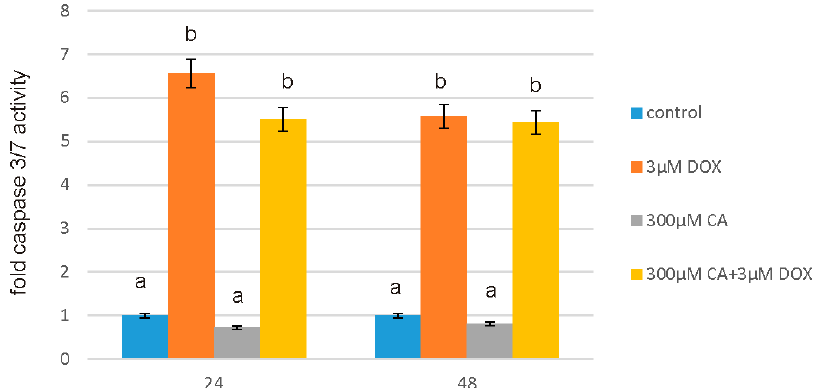
Figure 4. The effect of DOX, CA and CA + DOX on caspase 3/7 activity in fibroblast cells. The cells were incubated with 3 μ M DOX, 300 μ M CA and DOX (3 μ M) combined with CA (300 μ M) for 24 h and 48 h Mean values from three independent experiments ± SD are shown. Different letters (a, b) indicate statistical differences ( p ≤ 0.05) between control, 3 μ M DOX, 300 μ M CA and DOX combined with CA estimated by Tukey’s test.